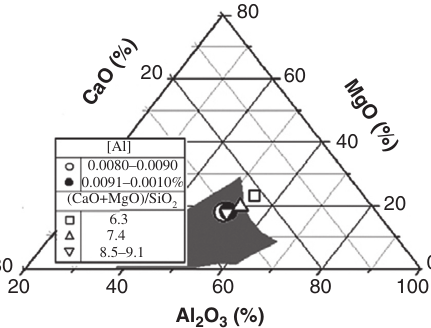
Figure 6 : Influences of [Al] and slag basicity on composition of the inclusions [9].